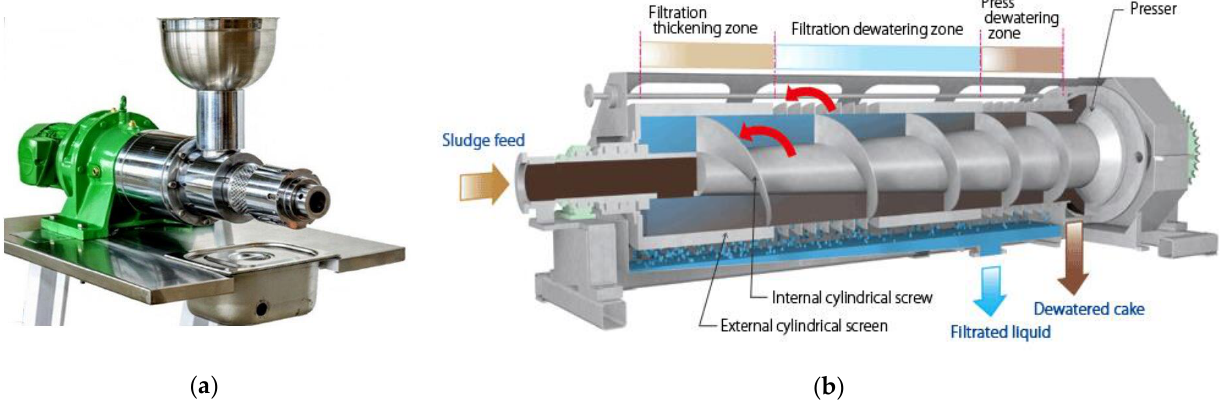
Figure 5. Two common types of screw expellers used for the cold pressing of hemp, ( a ) feed from top and ( b ) feed from front.